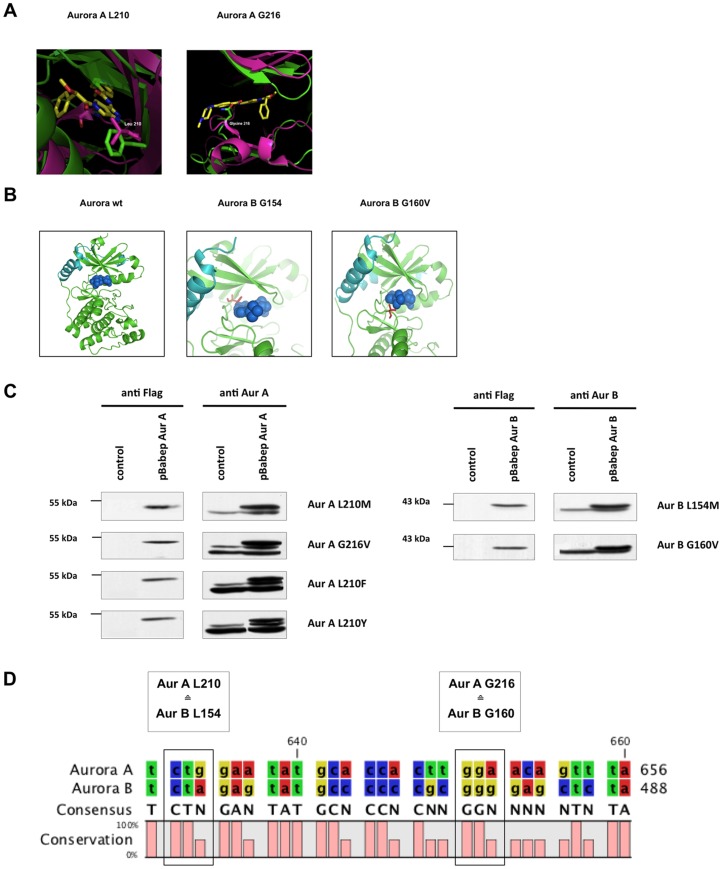
Characterization of Aurora model system.Crystal structure was analyzed in order to identify residues, whose specific mutation should abolish inhibitor binding while keeping Aurora kinase activity. (A) Superimposition of the CK2 crystal structure (green) with Aurora A (pink) - PHA-739358 (yellow) complex crystal structure, showing the position of the point mutation L210 and G216. (B) Xenpus laevis Aurora B (green) and INCENP (turquoise) in complex with AS7035369, showing the position of the point mutation L154 and G160. (C) Ba/F3 p185 wt cells were transfected with Babe-puro based retrovirus encoding AurA L210M, AurA G216V, AurB L154M, or AurB G160V point mutations. Empty pBabe-vector was used as control. Selection was accomplished with puromycin. Western blot analysis showing flag-tagged Aurora A and B expression similar to endogenous Aurora A/B protein levels. (D) Amino acid sequence alignment of human Aurora kinase A and B. Mutated residues are framed. It is of note that the point mutations L210M and G216V in Aurora A accord with L154M and G160V in Aurora B.